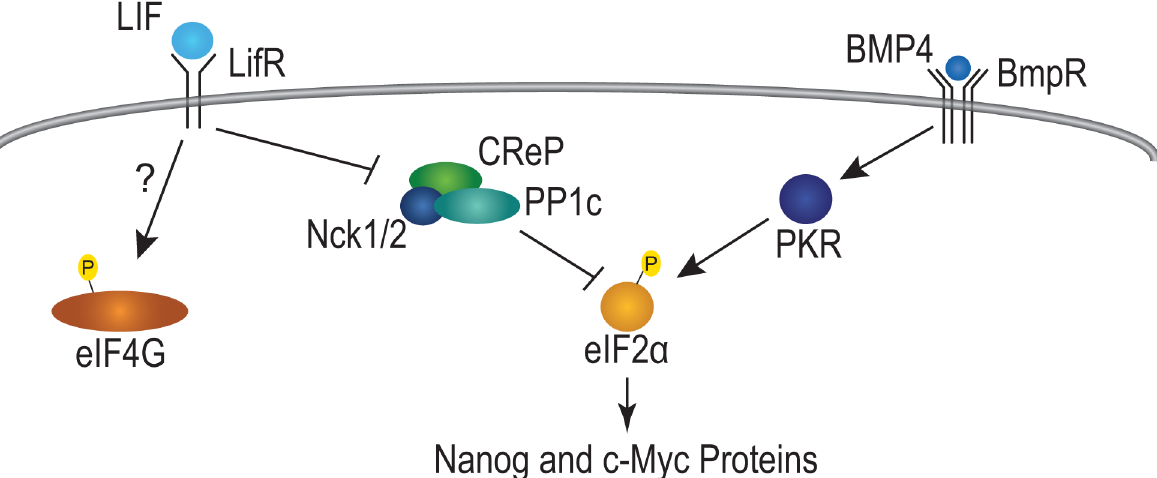
Fig 5. LIF and BMP4 regulate eIF2 α phosphorylation and translation initiation. A model for how LIF and BMP4 regulate translation initiation. LIF and BMP4 bind receptors on the cell surface leading to decreased CReP and increased PKR activity respectively. LIF signals to phosphorylate eIF4G via an unknown pathway. CReP loss and PKR activation increase P-eIF2 α